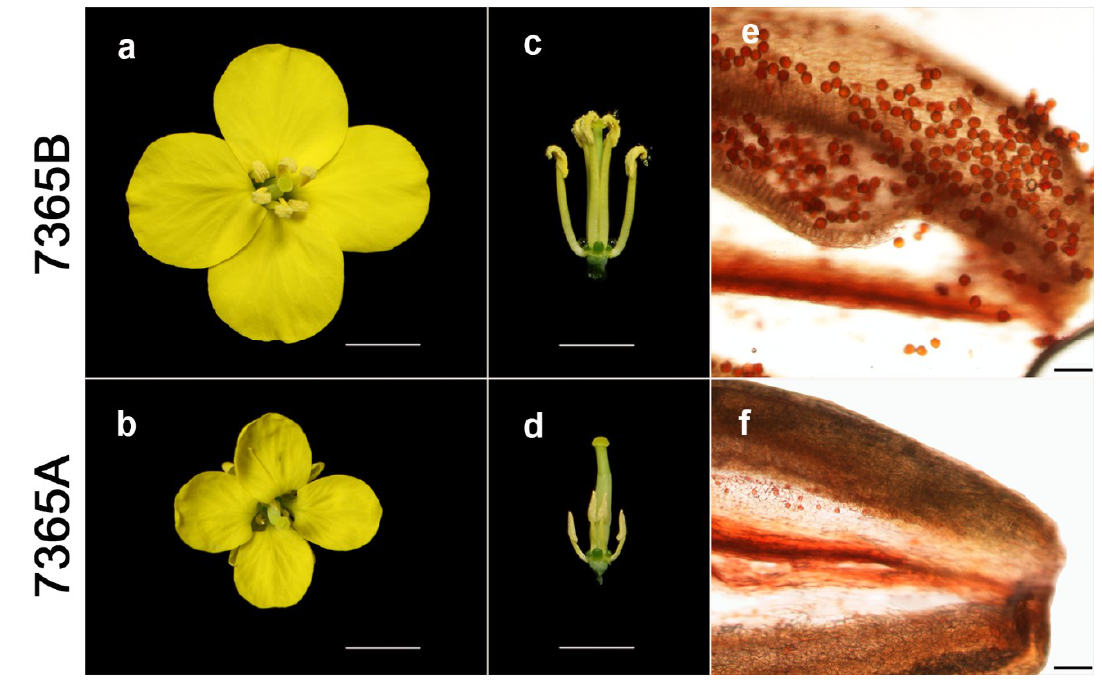
Figure 1. Phenotypic characterization of fertile and sterile lines. ( a , b ) Vertical‐view of open flowers; ( c , d ) Side‐view of flowers without calyxes and petals; ( e , f ) Acetocarmine‐stained anthers; a, c and e are 7365B; b, d and f are 7365A. The scale bars are 5 mm for a, b, c and d, and 100 μm for e and f.